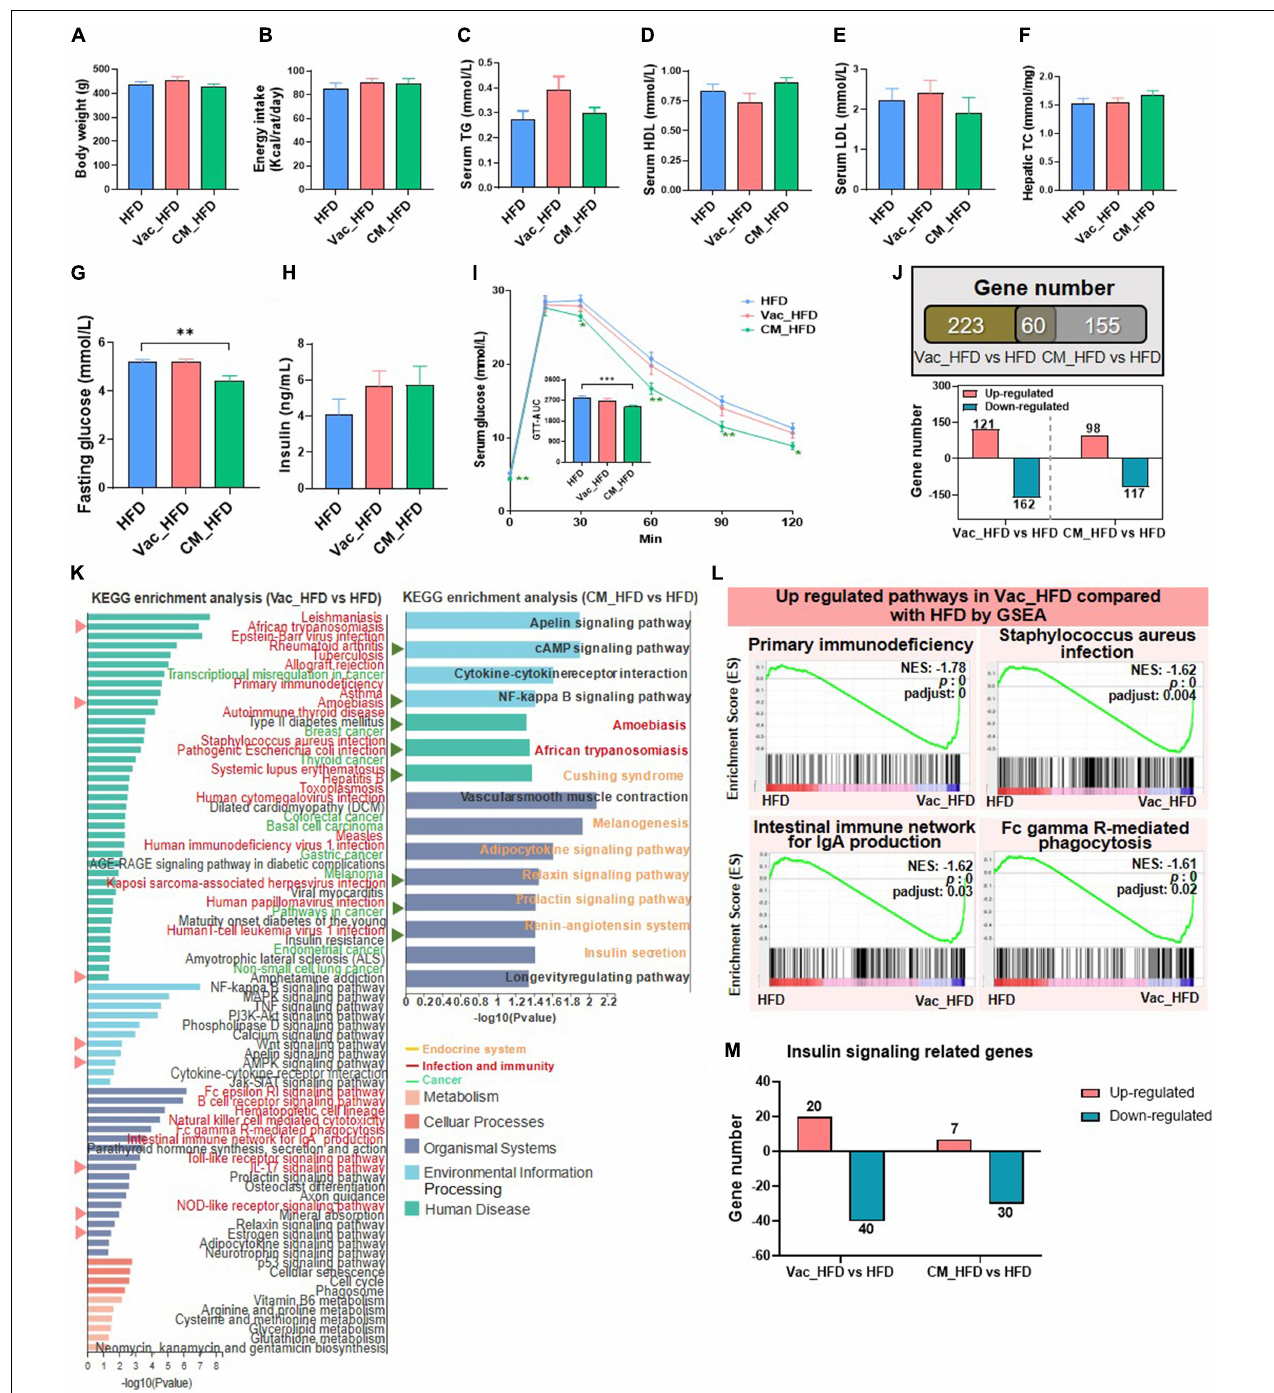
FIGURE 6 | High-fat diet affects post-antibiotic recovery of rat phenotype and hepatic transcriptome. The body weight (A) , energy intake (B) , serum triglyceride level (C) , serum high-density lipoprotein level (D) , serum low-density lipoprotein level (E) , and liver total cholesterol level (F) were shown at the end of the 45-day recovery. (G–I) Fasting blood glucose level, fasting blood insulin level, and glucose tolerance test result. (J) Venn diagram of the overlap of differential expressed genes between Vac_HFD vs. HFD and CM_HFD vs. HFD ( p < 0.05 based on edgeR software, and FC ≤ 0.5 or ≥ 2). (K) KEGG pathway enrichment analysis of 283 and 215 differential genes. Triangles on the left showed the same pathways between Vac_HFD vs. HFD and CM_HFD vs. HFD. (L) The same pathways between Gene Set Enrichment analysis (GSEA) and KEGG pathway enrichment analysis. (M) Different regulatory effects of Vac and CM on insulin-related genes. n = 9–10 per group for biochemical analysis, ** p < 0.01 and *** p < 0.001 by Student’s t -test; n = 3 per group for transcriptome, Mann–Whitney U test.